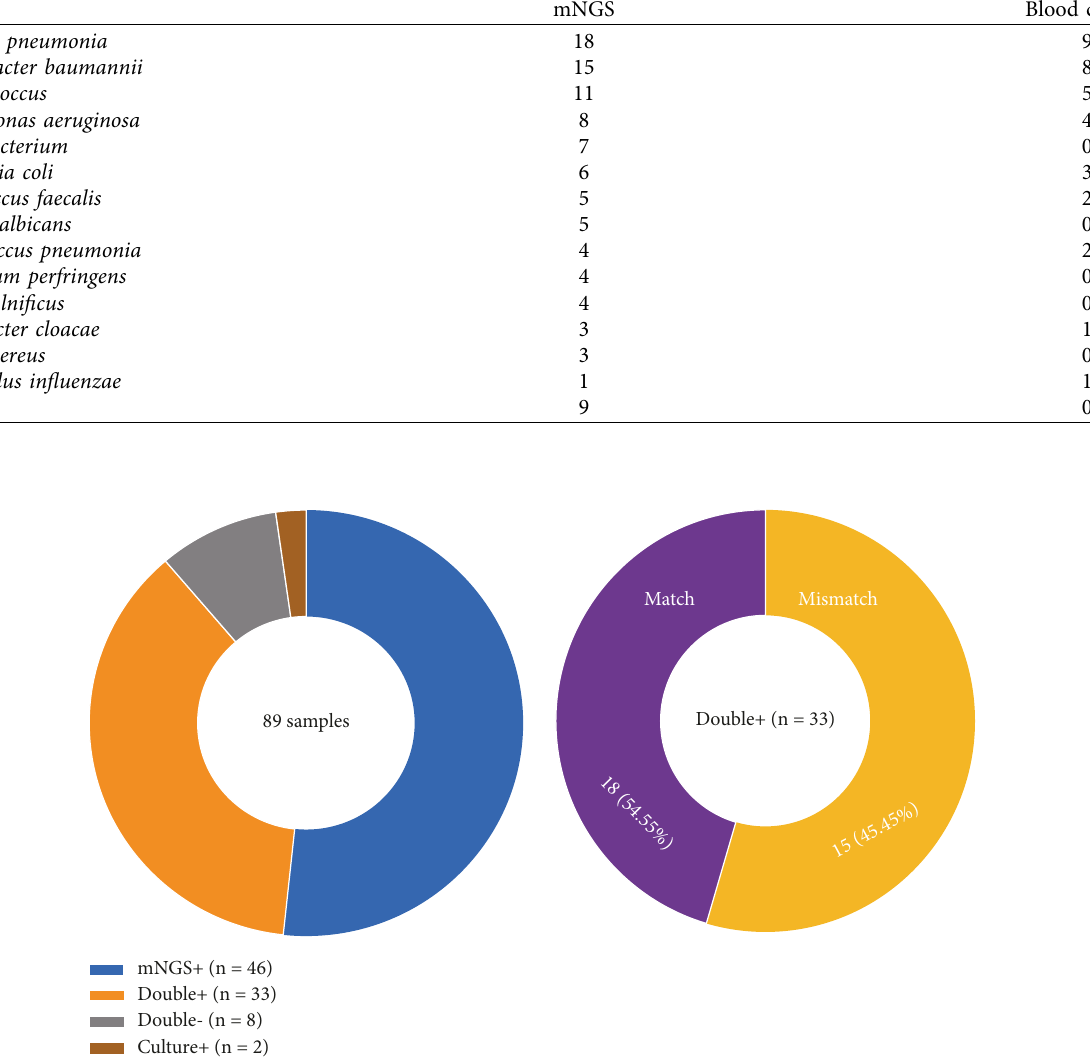
Figure 1: Comparison of pathogen detection between standard microbiological blood cultures and